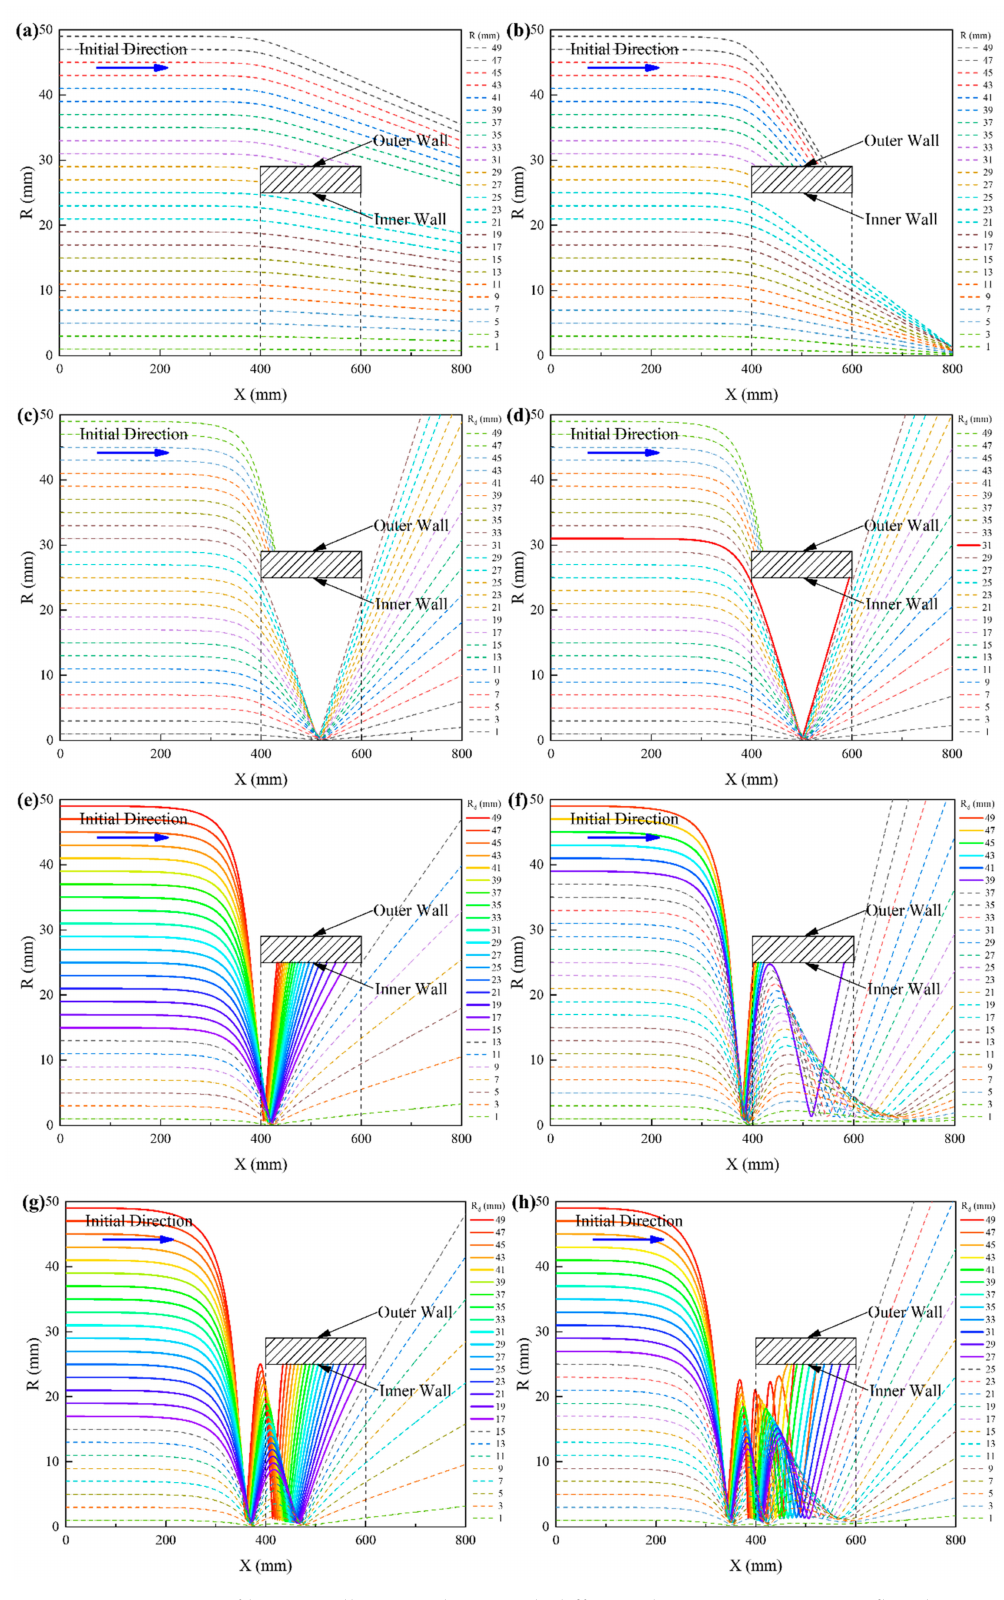
Figure 7. Trajectories of horizontally emitted ions with di ff erent characteristic magnetic flux densities: ( a ) 230 Gs; ( b ) 690 Gs; ( c ) 920 Gs; ( d ) 977 Gs; ( e ) 1840 Gs; ( f ) 2622 Gs; ( g ) 3450 Gs; ( h ) 4600